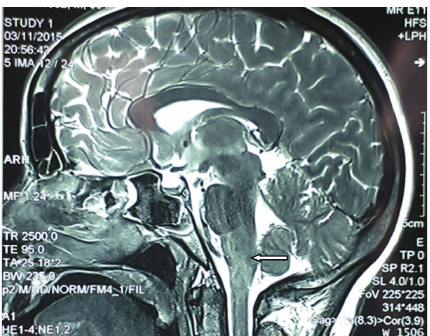
Figure 1: MRI of the brain in sagittal section showing hyperinten- sities at the cervicomedullary junction (white arrow).